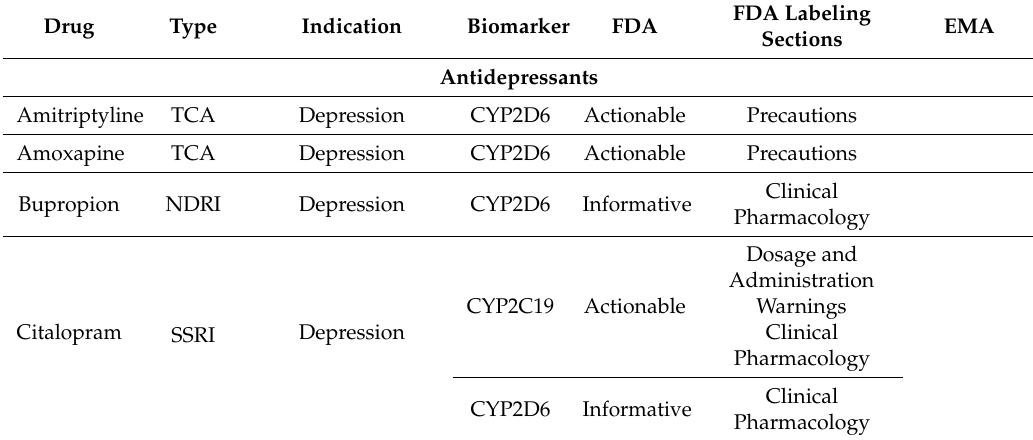
Table 1. Food and Drug Administration (FDA) pharmacogenomic biomarkers in drug labeling in